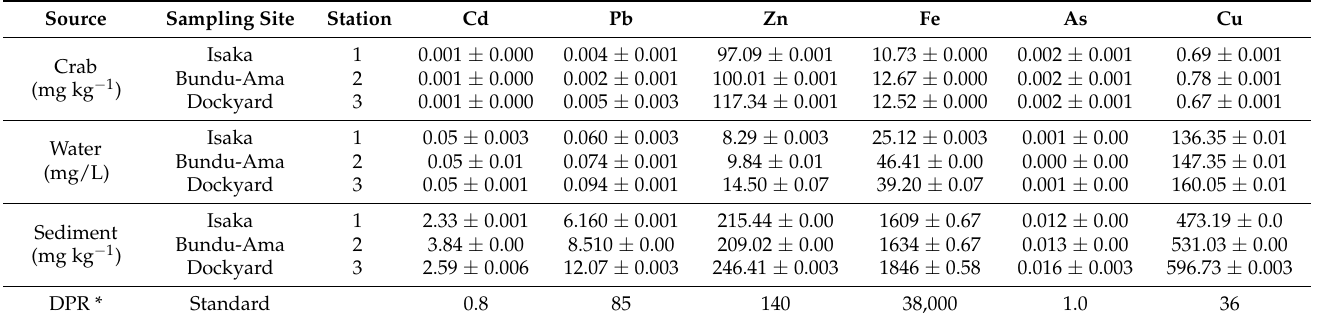
Table 2. Mean concentrations (mg kg − 1 dry weight for fish and sediment; mg/L for water) of Pb, Cd, Zn, Fe, As, and Cu from the various media in the Isaka–Bundu tidal mangrove swamp.